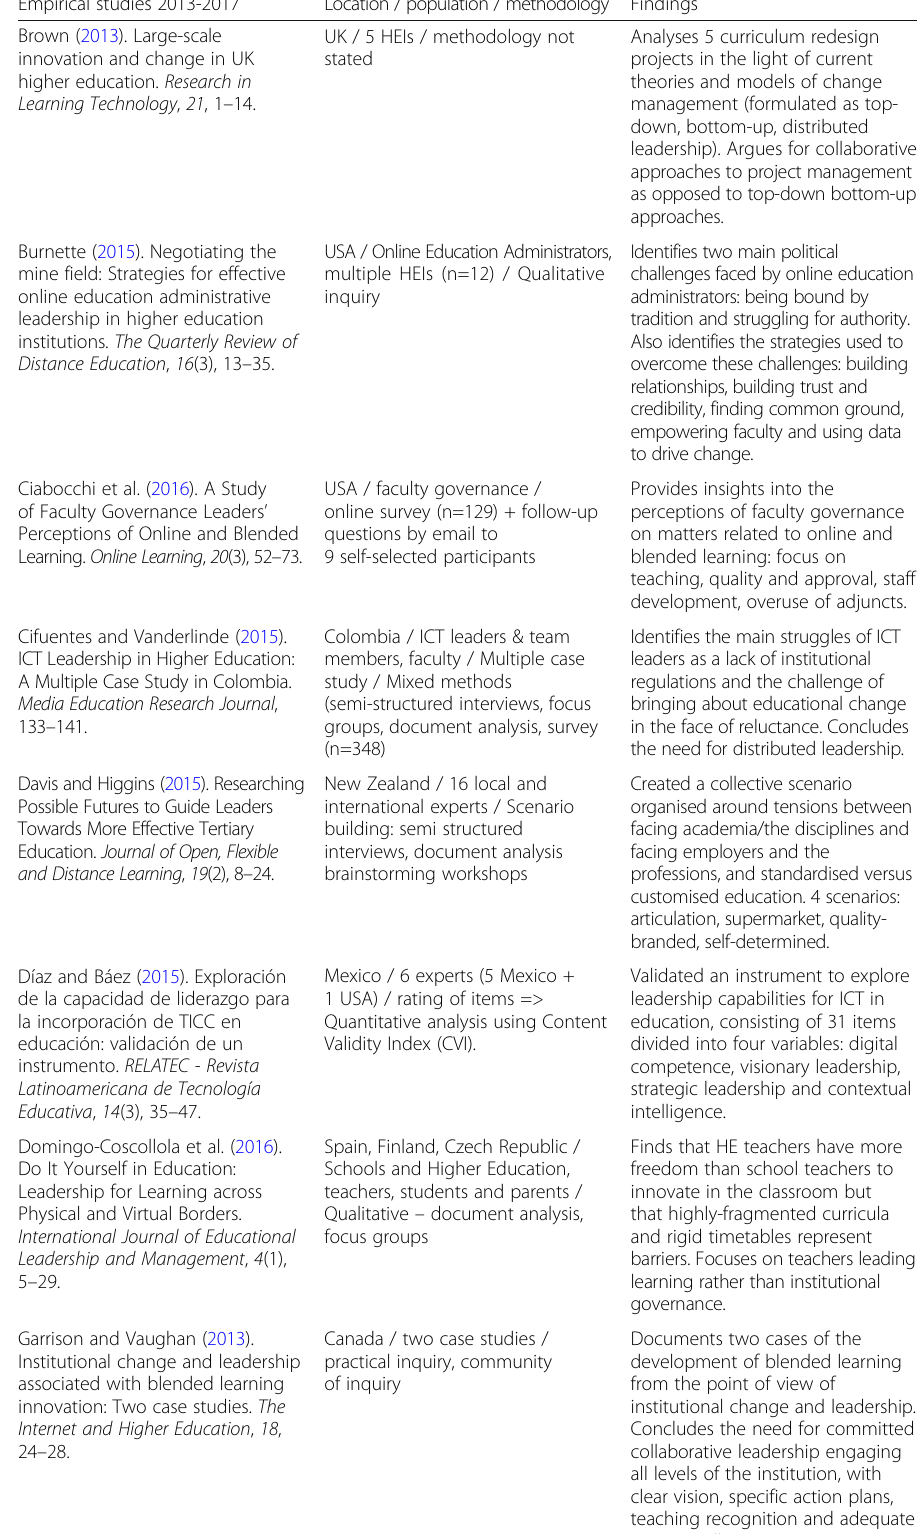
Table 2 Results: Empirical studies (Continued) Empirical studies 2013-2017 Location / population / methodology Findings Brown (2013). Large-scale innovation and change in